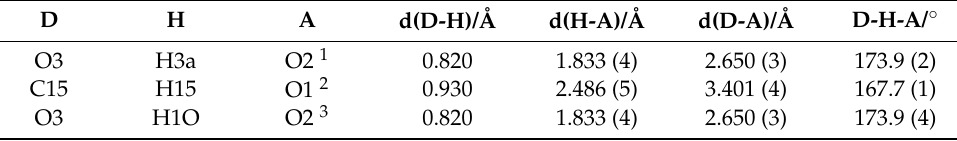
Table 6. Hydrogen bonds for 3a .